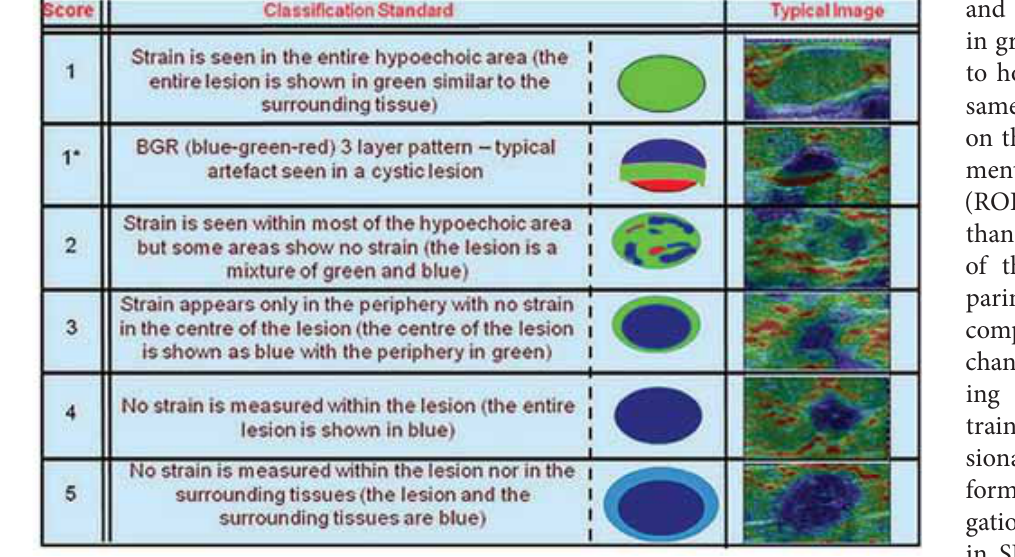
FIGURE 2. Sonoelastographic classi(cid:144) cation by the Italian MultiCenter Team of study